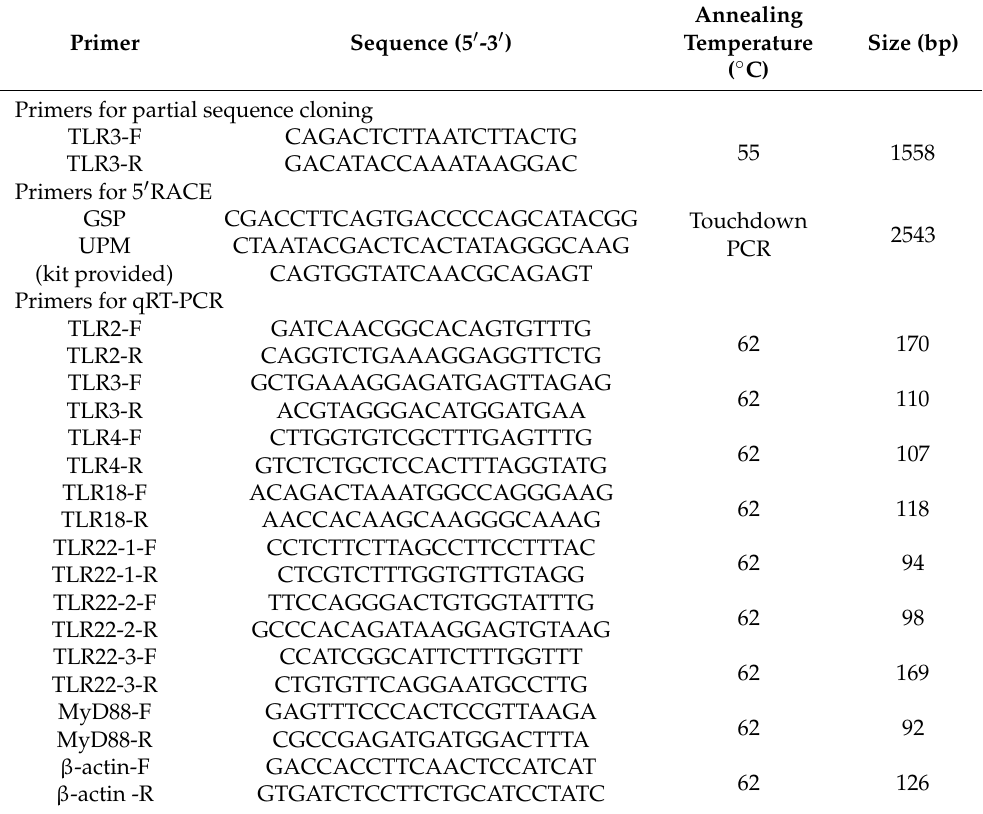
Table 1. The primers used for SpTLR3 clone and